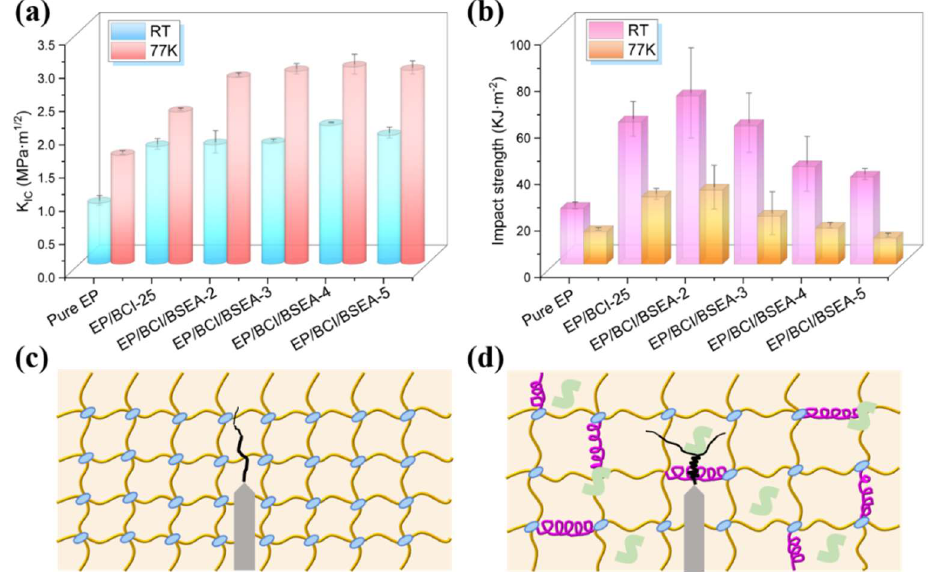
Figure 9. ( a ) K IC and ( b ) impact strength of EP composites at RT and 77 K; schematic diagram of crack propagation for fracture toughness tests of ( c ) pure EP and ( d ) modified EP.